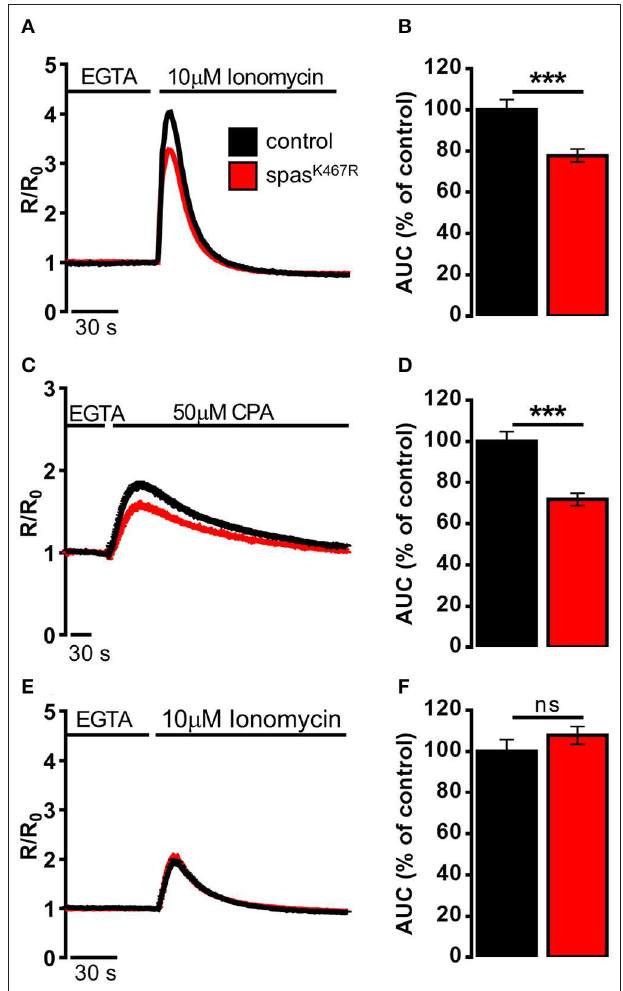
FIGURE 3 | Ca 2 + dynamics induced by (A,B) ionomycin, (C,D) CPA, (E,F) ionomycin after CPA-induced ER depletion in neurons dissociated from larval brains expressing spastin K467R , and relative controls, detected by fura-2. (A,C,E) Cells were stimulated with (A,E) 10 µ M ionomycin or (C) 50 µ M CPA in the presence of extracellular Ca 2 + chelator EGTA. In all panels, average traces are represented as R/R 0 values of n > 100 cells. (B,D,F) Histograms report the average area under curve (AUC) values of the traces recorded. Data are presented as mean ± SEM of n > 100 cells. *** p <